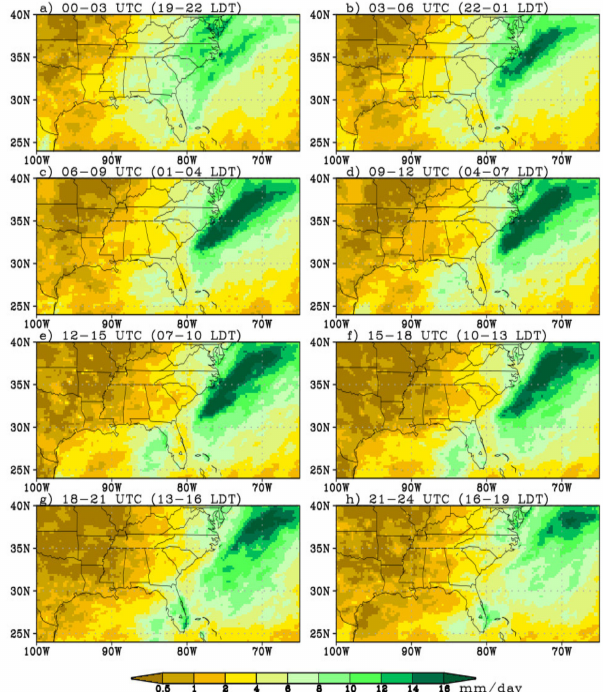
Figure 7. Diurnal cycle of CMORPH precipitation for WT1. LDT: U.S. eastern time, i.e., local daylight time at 75 ◦ W, which is five hours later than the Coordinated Universal Time (UTC). Subfigures ( a – h ) show 3-hourly average precipitation rate (mm/day) in 00–03 UTC, 03–06 UTC, 06–09 UTC,